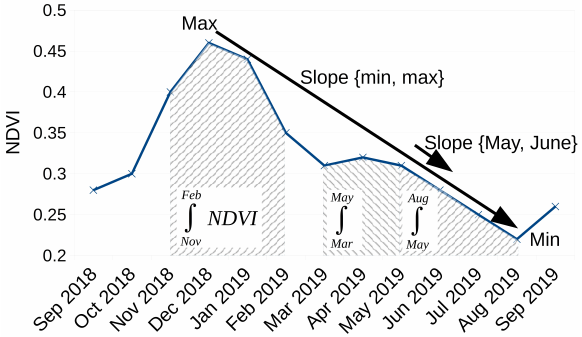
Figure 4. Graphical representation of a temporal NDVI curve with the phenology-related features computed per parcel from the Sentinel-2